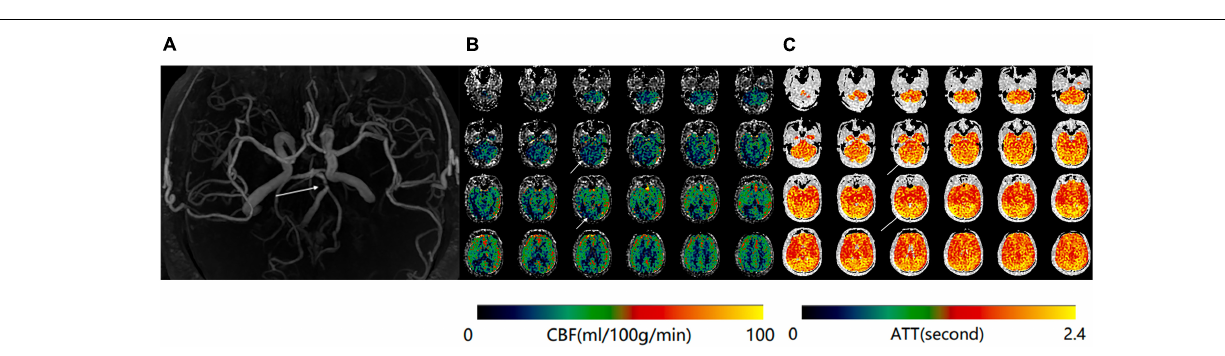
FIGURE 3 | (A) Magnetic resonance angiography (MRA) of a 70-year-old man shows severe stenosis of the basilar artery. (B) Maps of mean cerebral blood flow (mCBF) demonstrate markedly decreased blood flow in the bilateral occipital lobes and cerebellum. (C) Arterial transit time (ATT) maps shows increased signal at the same anatomical